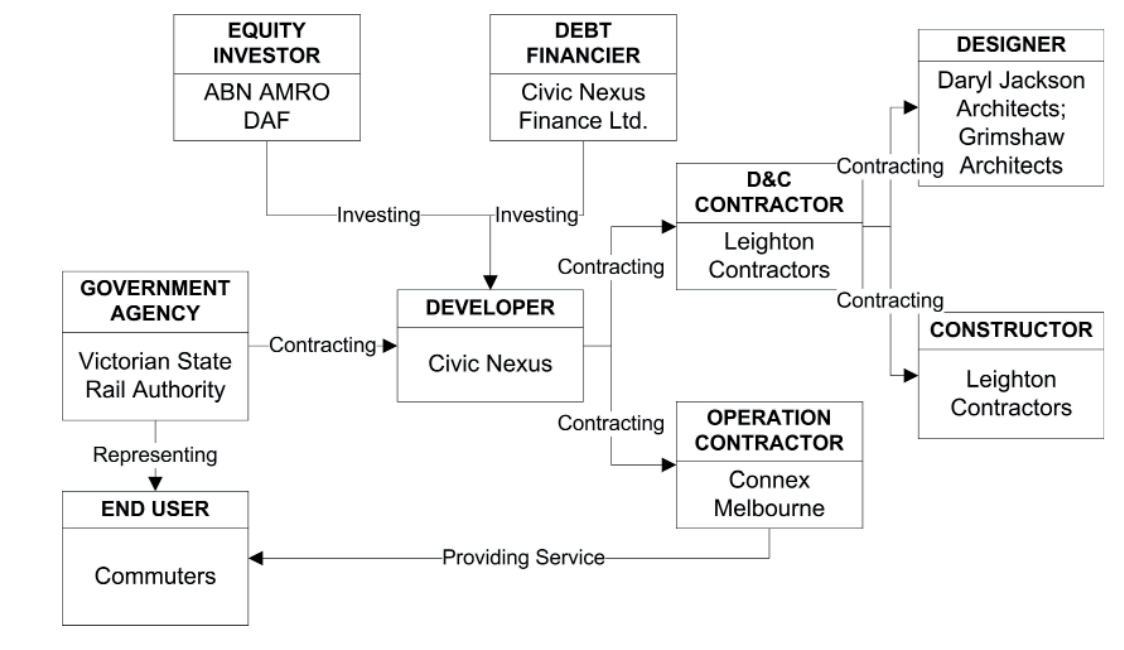
Figure 1: Major stakeholders in the Southern Cross Station redevelopment